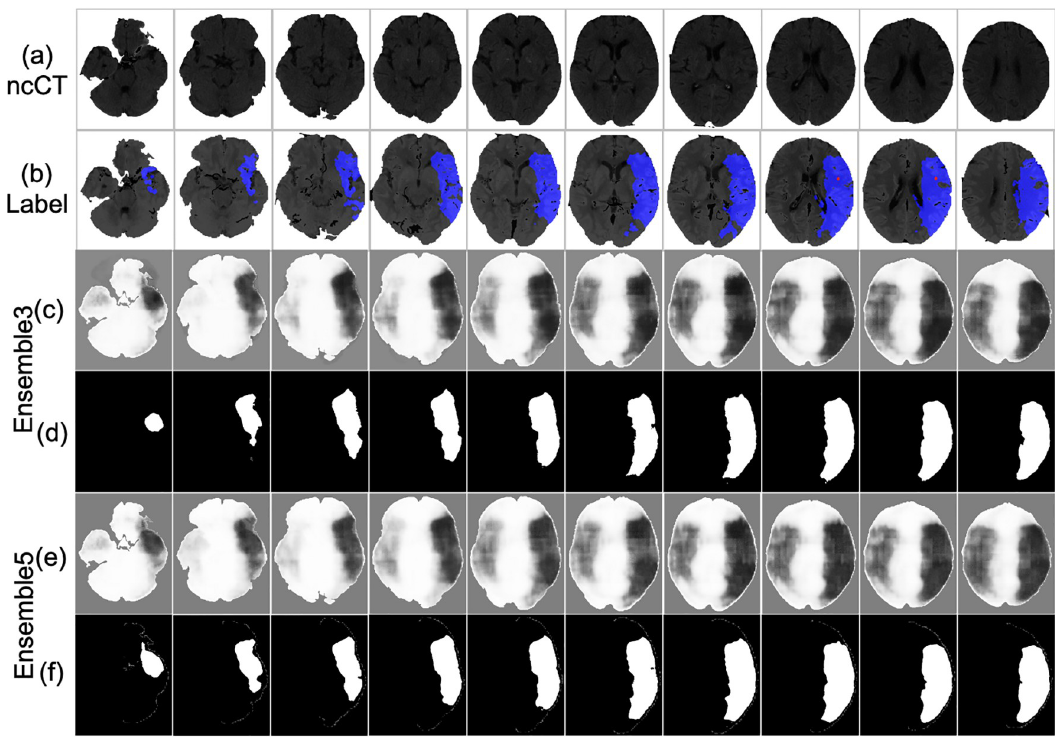
Fig 13. Lesion detection of the original ncCT (a) label on CTp (b) of the case that achieved the best segmentation result. (c) Ensemble3 (e) Ensemble5 without postproceessing (d) Ensemble3 (f) Ensemble5 with postproceessing.